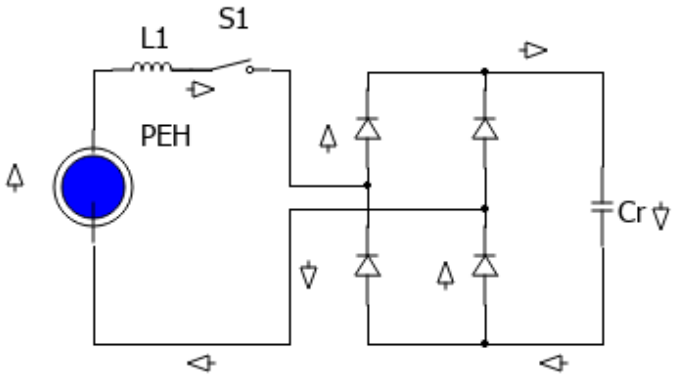
Figure 7. Schematic of S-SSHI energy extraction interface.